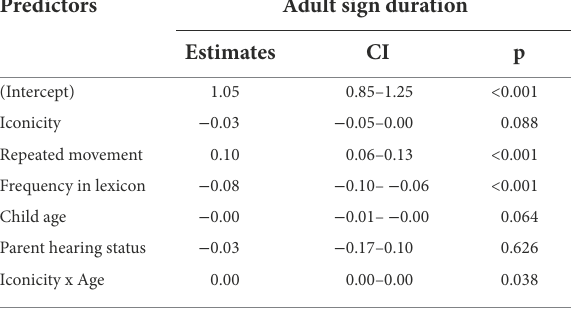
TABLE 1 Results of the model predicting sign